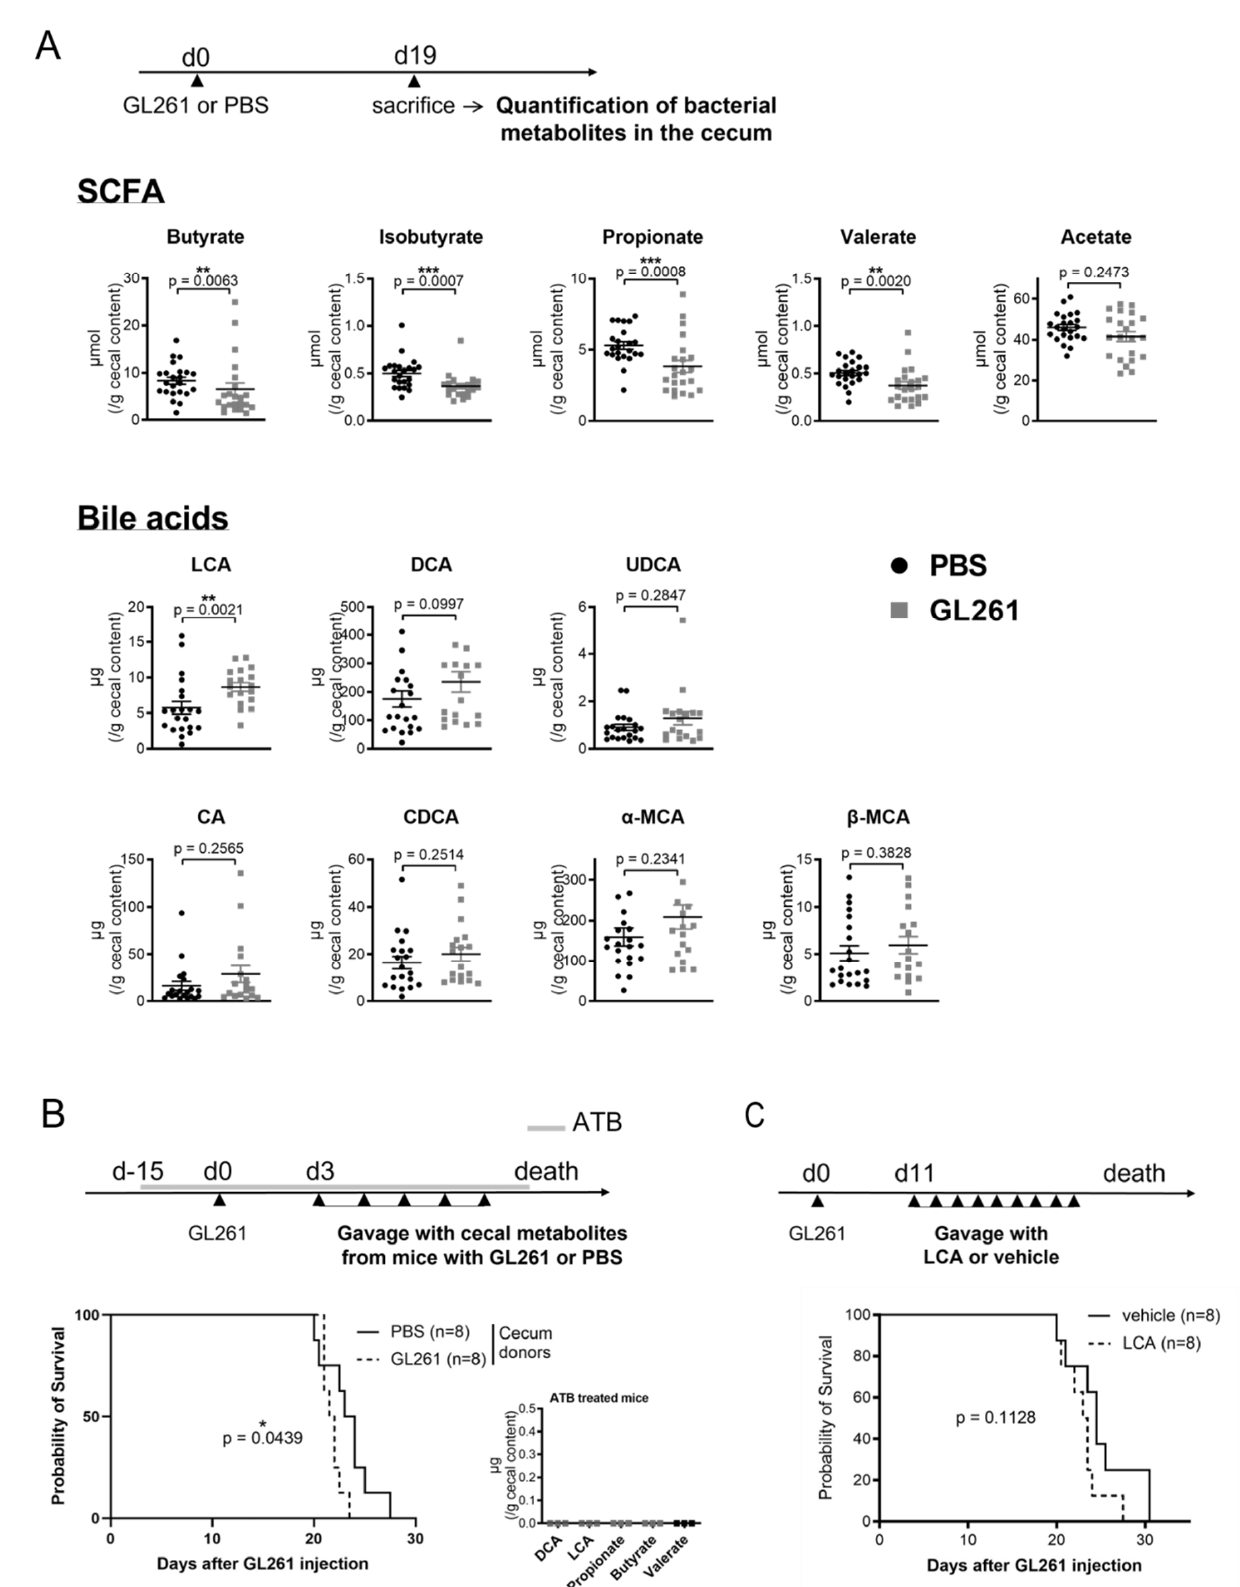
Figure 2. Late-stage glioma is associated with a shift in bacterial metabolites in the cecum, which speed up mice death upon transfer ( A ) Quantification of short-chain fatty acids (SCFA) (PBS n = 23; GL261 n = 22) and bile acids (PBS n = 20–21; GL261 n = 17–18) in the cecum of mice injected with GL261 or PBS, 19 days after the surgery. UDCA: ursodeoxycholic acid; DCA: deoxycholic acid; LCA: lithocholic acid; CA: cholic acid; CDCA: chenodeoxycholic acid; MCA: muricholic acid. Statistical analyses were performed with the Mann–Whitney U -test, ** 0.001 ≤ p < 0.01, *** 0.0001 ≤ p < 0.001.